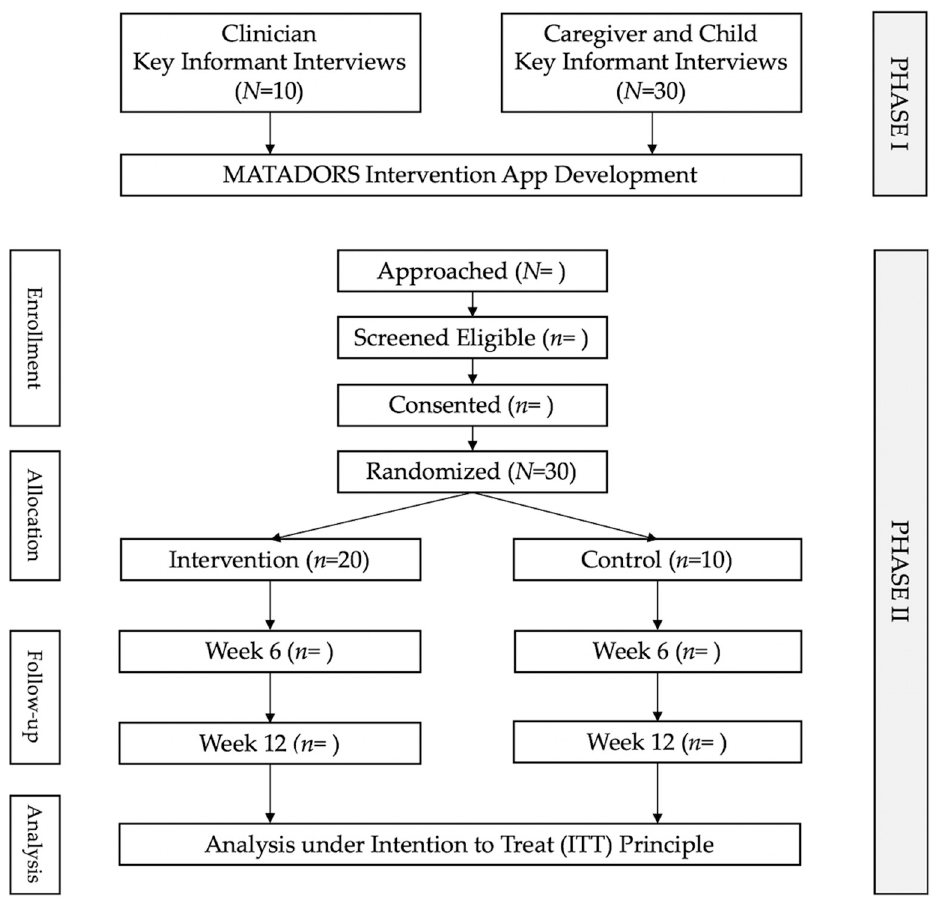
Figure 1. CONSORT Figure 1. CONSORT Flowchart.